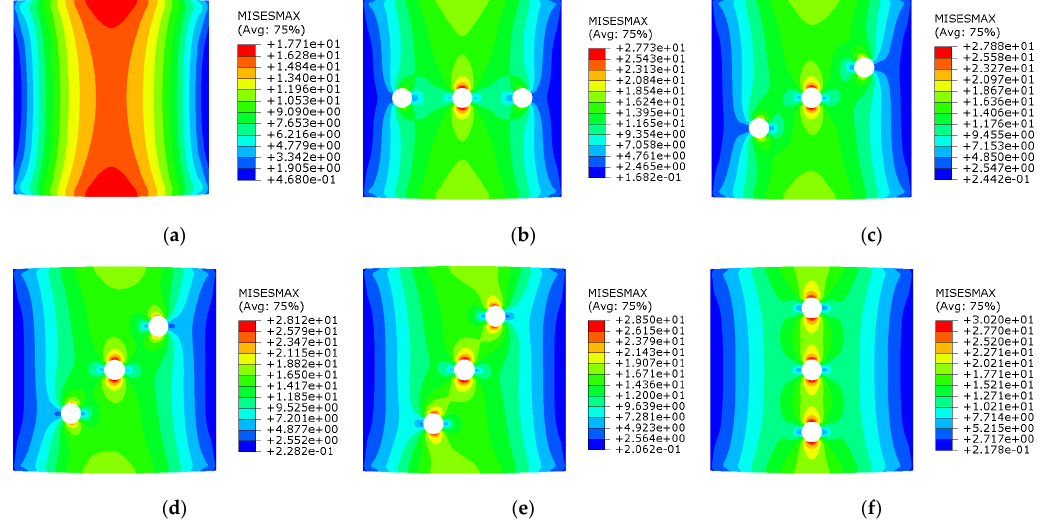
Figure 5 . Von Mises stress of FGM plates with ( a ) a plate thickness of 50 mm, a cutout diameter of 200 mm with an arrangement of ( b ) 0 ° , ( c ) 30 ° , ( d ) 45 ° , ( e ) 60 °, and ( f ) 90 ° .